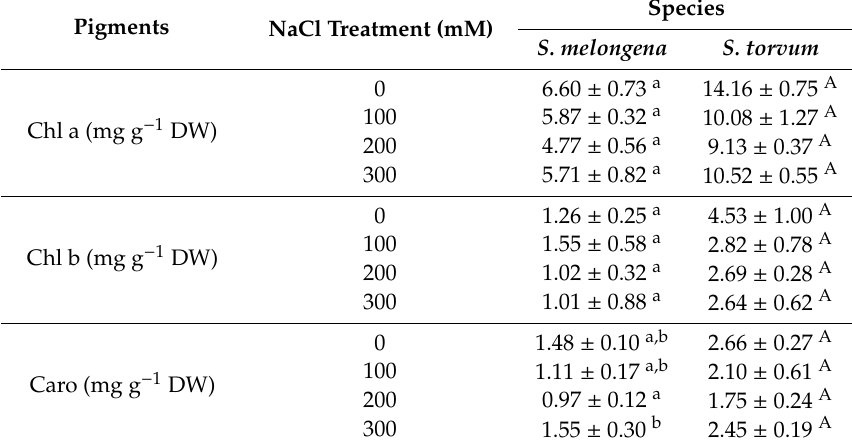
Table 3. Chlorophyll a (Chl a), chlorophyll b (Chl b), and carotenoids (Caro) leaf contents (mean ± SE, n = 5) of S. melongena and S. torvum plants, after 25 days of treatment with the indicated NaCl concentrations.